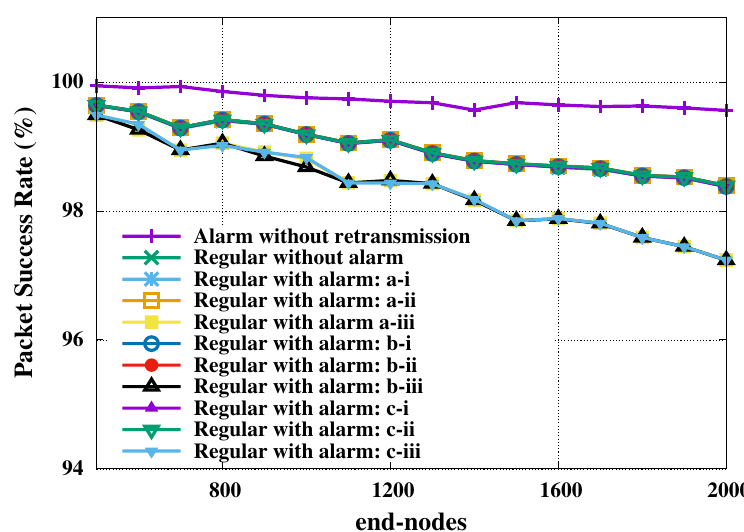
Figure 7. Regular and alarm nodes’ packet success rate for open field and four gateways. Regarding a 95% confidence level, the largest margins of error, in percentage points, are: 0.177 (alarm